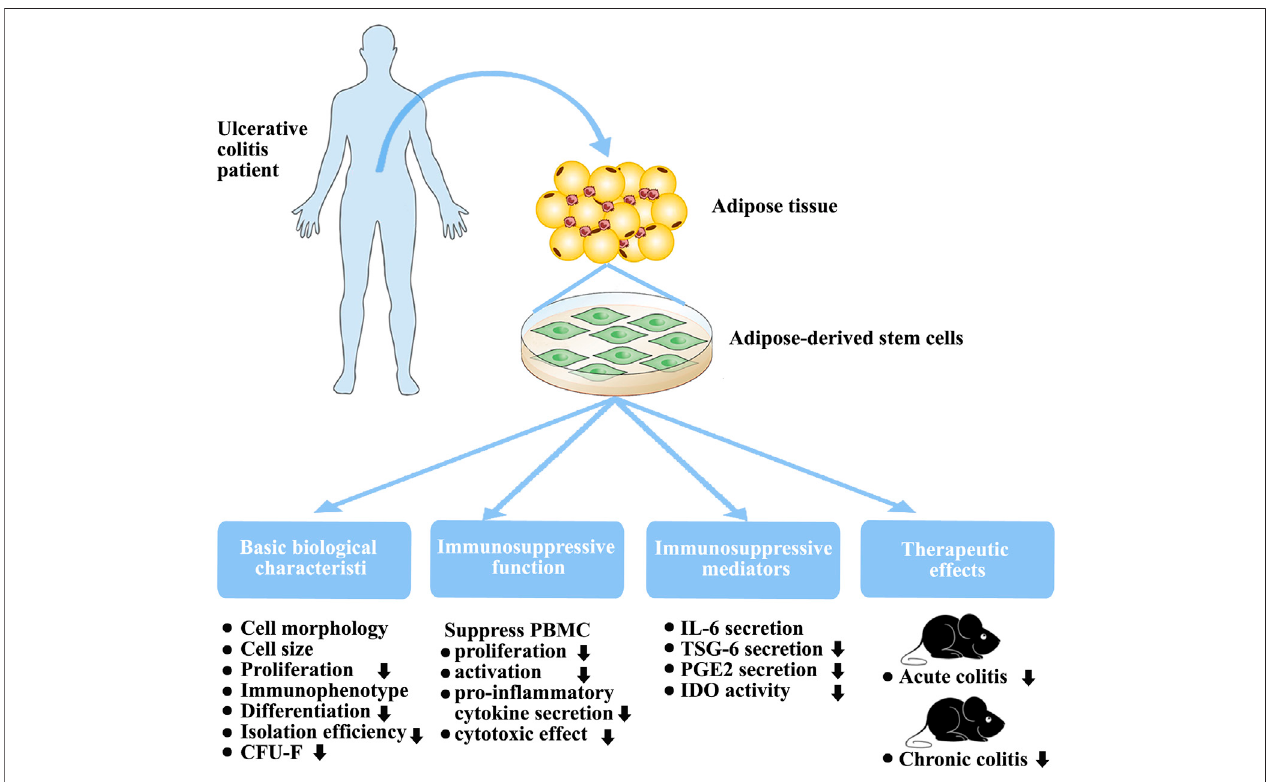
FIGURE 8 | Biological characteristics, immunosuppressive function, and therapeutic effects of in vitro-expanded ADSCs from patients with UC.